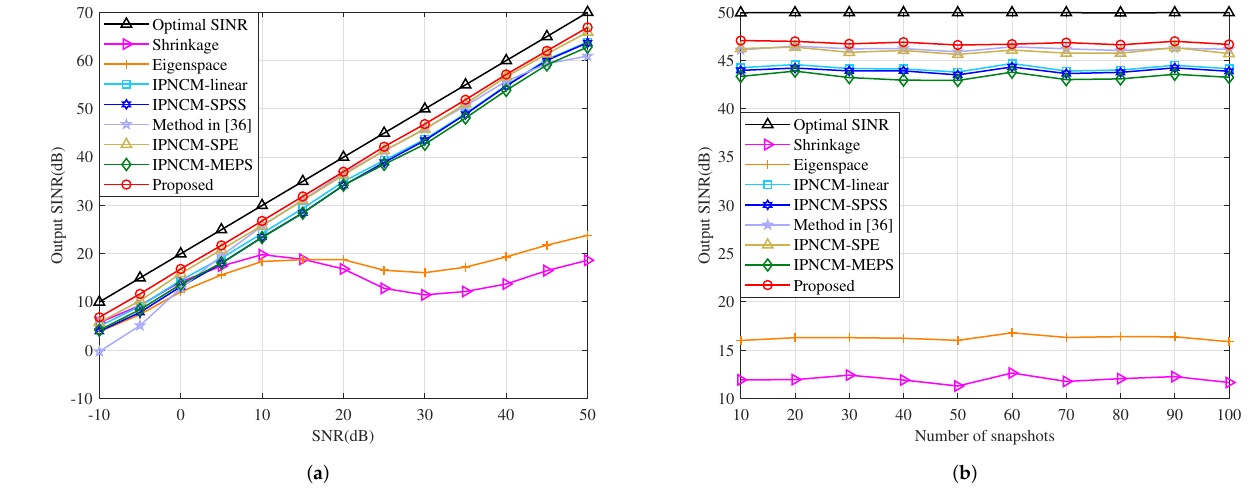
Figure 14. Output SINR in the case of coherent local scattering versus ( a ) input SNR, JNR = 30 dB, K = 50. ( b ) the number of snapshots, SNR = 30 dB, JNR = 30